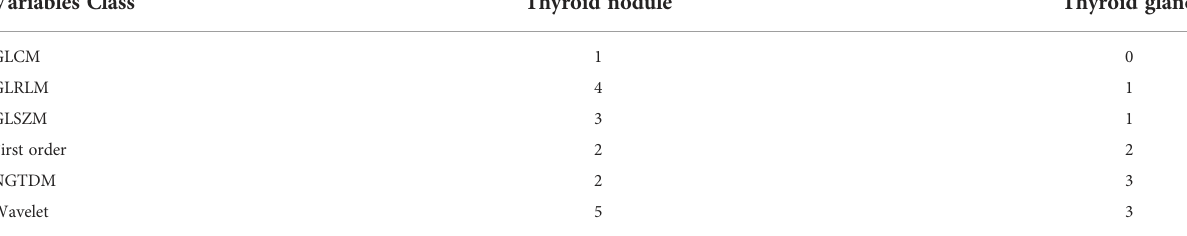
TABLE 3 The Class of Extracted